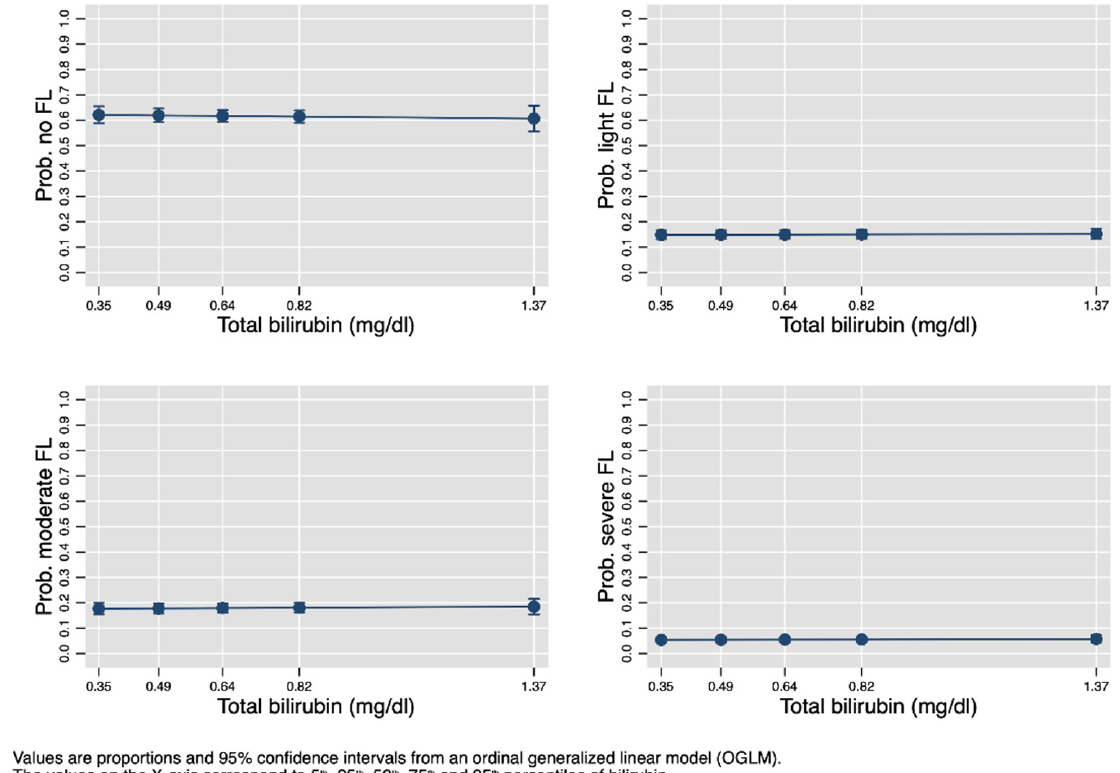
Figure 5. Association between serum total bilirubin and fatty liver degree.